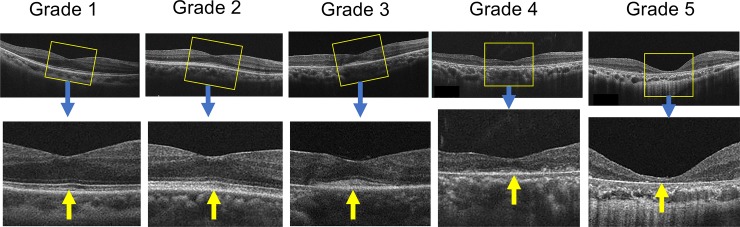
Sample SD-OCT pictures indicating each severity grade.Definition of grades: grade 1, almost a normal foveal structure or sharply defined IS-EZ and IZ at the foveal center (yellow arrow); grade 2, partial hyperreflective changes in the IS/OS layer of the foveal region or a broadened IZ (yellow arrow) and/or IS-EZ without merging; grade 3, diffuse hyperreflective changes in the IS/OS layer or broad IS-EZ changes in the foveal region or merging of the broadened IS-EZ and IZ (yellow arrow); grade 4, remnants of the IS/OS-like structure on the retinal pigment epithelium (yellow arrow); grade 5, absent IS/OS-like structure (yellow arrow).